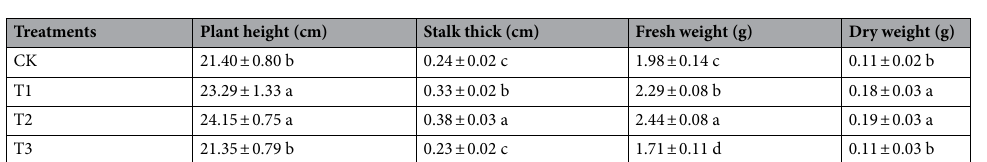
Table 3. Effect of different treatments on disease resistance of maize at seedling stage. Different letters indicate significant differences at p < 0.05 (according to Duncan’s multiple range test).